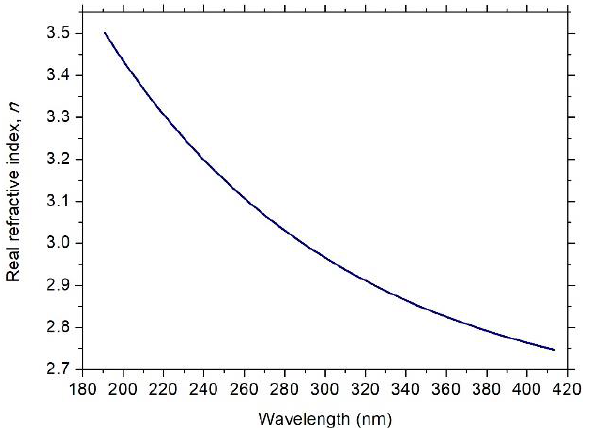
Figure 3. 4H − SiC real refractive index vs. wavelength measured through ellipsometry.